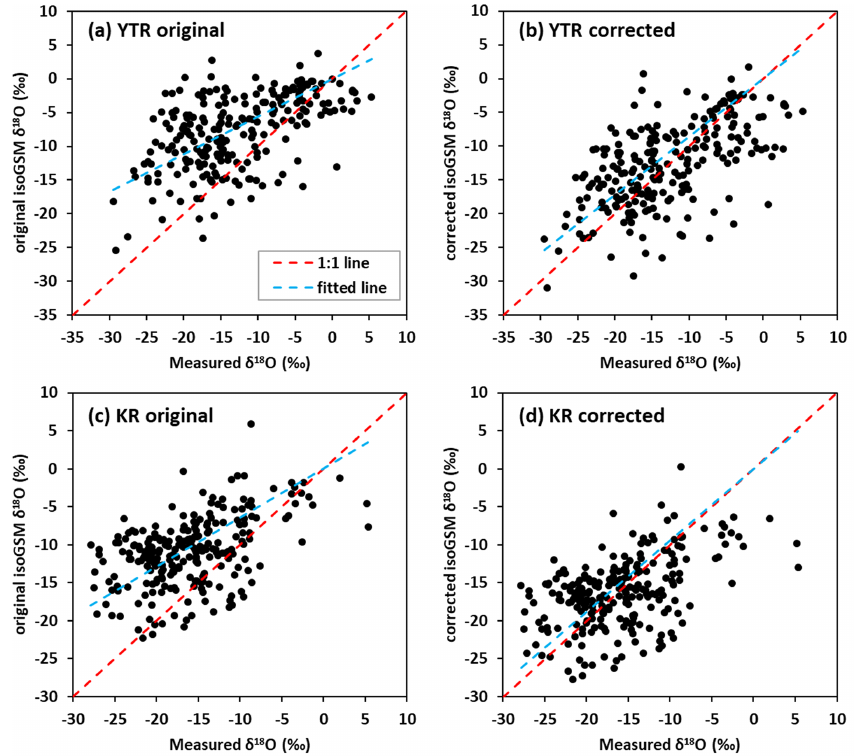
Figure 2. The scatter diagrams between the original/corrected isoGSM and measured isotope data in the YTR basin (a, b) and KR catchment (c, d)